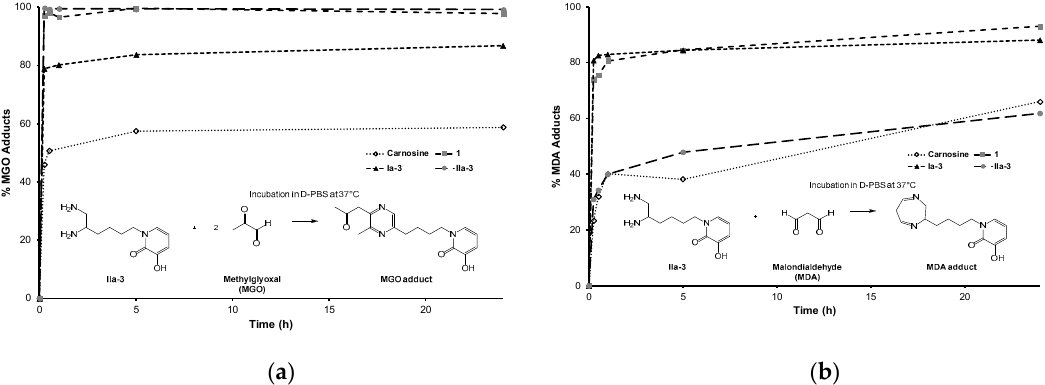
Figure 4. Kinetic curves representing the formation of ( a ) MGO or ( b ) MDA adducts in the presence of different scavengers. Tested compounds (10 mM) dissolved in D ‐ PBS (pH 7.4) were incubated with MGO or MDA (20 mM) at 37 °C for 24 h. Samples collected at regular time intervals were subsequently analyzed by LCMS. Area under the curve (AUC) of the MGO or MDA adduct peak and remaining free scavenger peak were measured on UV chromatogram at 190 nm. Data are expressed as percentage of total MGO or MDA adducts compared with remaining free scavenger for a representative single sample. ND: Not determined.